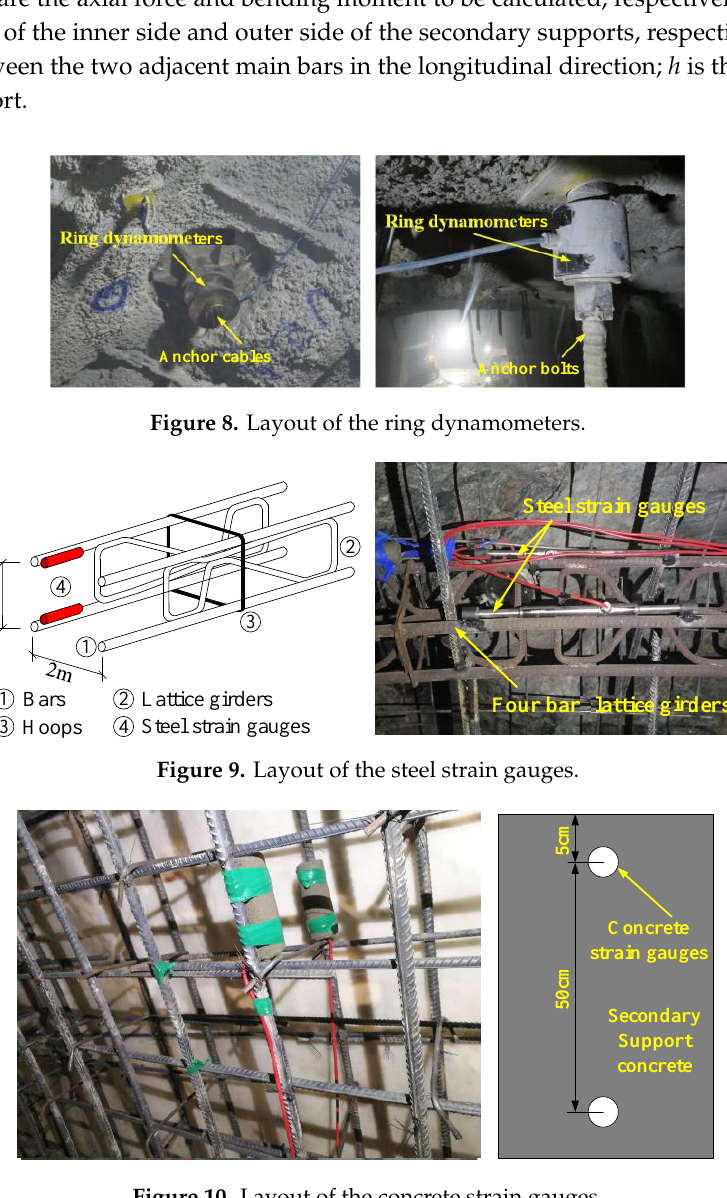
Figure 7. Layout of the earth pressure cells.